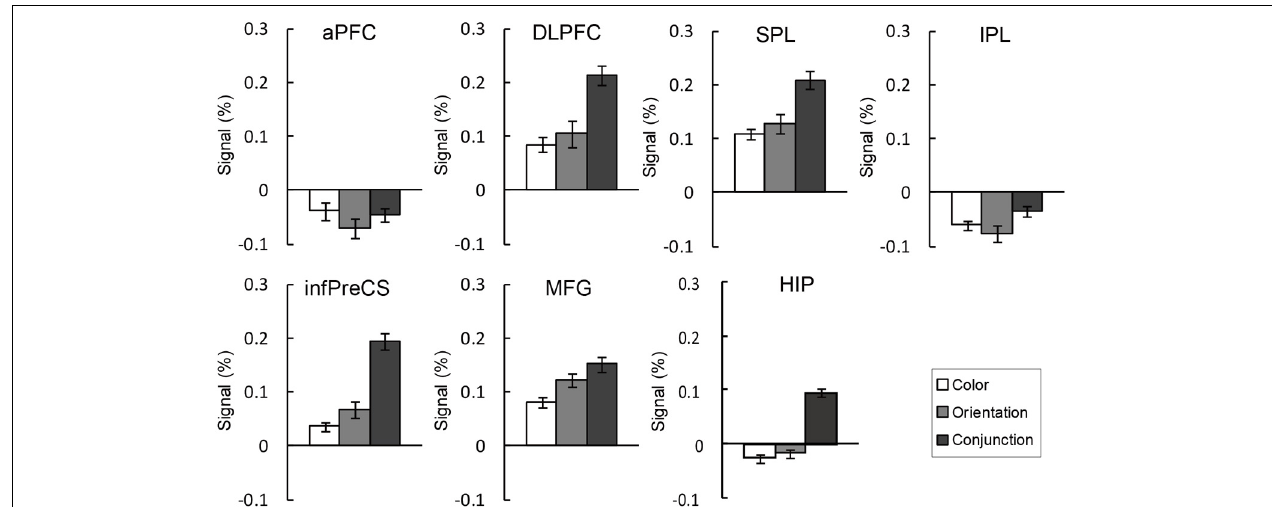
FIGURE 5 | BOLD signal change (%) extracted ROIs during the maintenance of the binding condition in the change detection tasks. The error bars represent